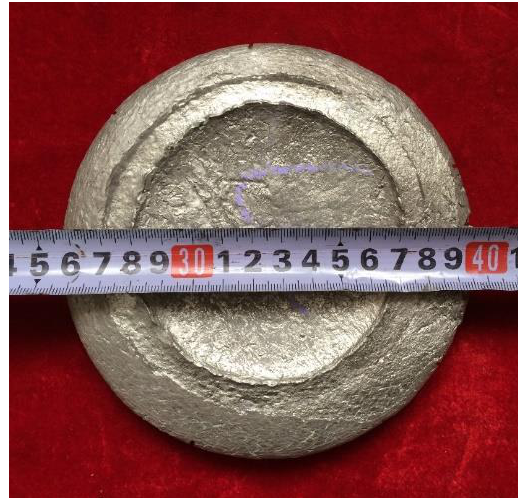
Figure 7. The appearance of the Ti–43Al–3Mn–2Nb–0.1Y billet.